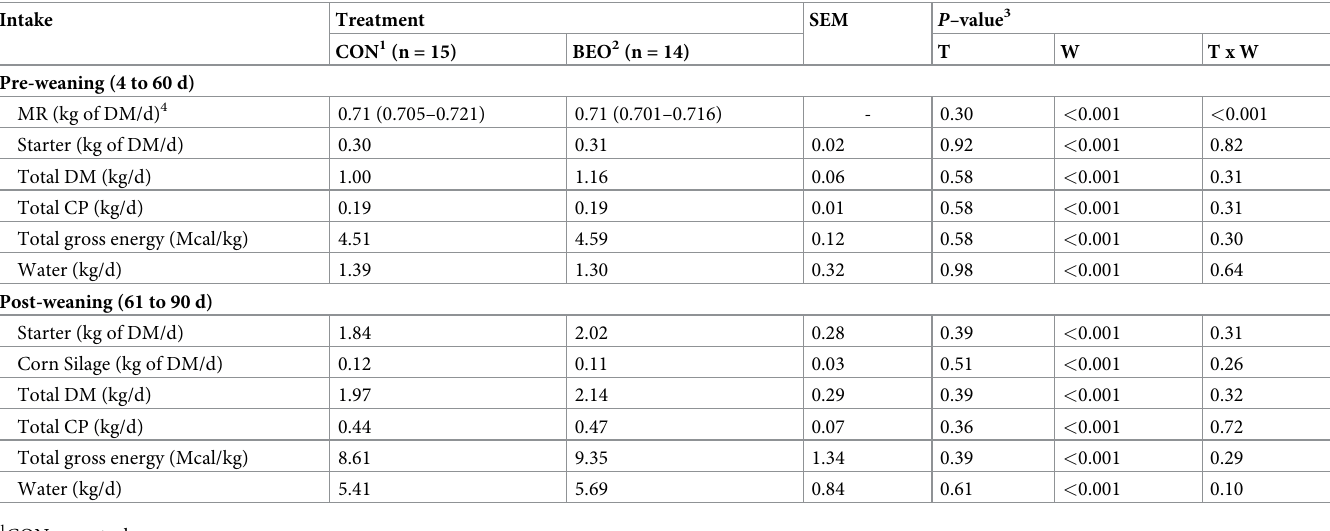
Table 2. Pre and post-weaning Milk Replacer (MR) intake, starter intake, total dry matter intake (DM), total crude protein intake (CP), total gross energy and water intake of heifers of control (CON) and supplemented with blend essential oils (BEO) in milk replacer during pre-weaning. Intake Treatment SEM P– value 3 CON 1 (n = 15) BEO 2 (n =